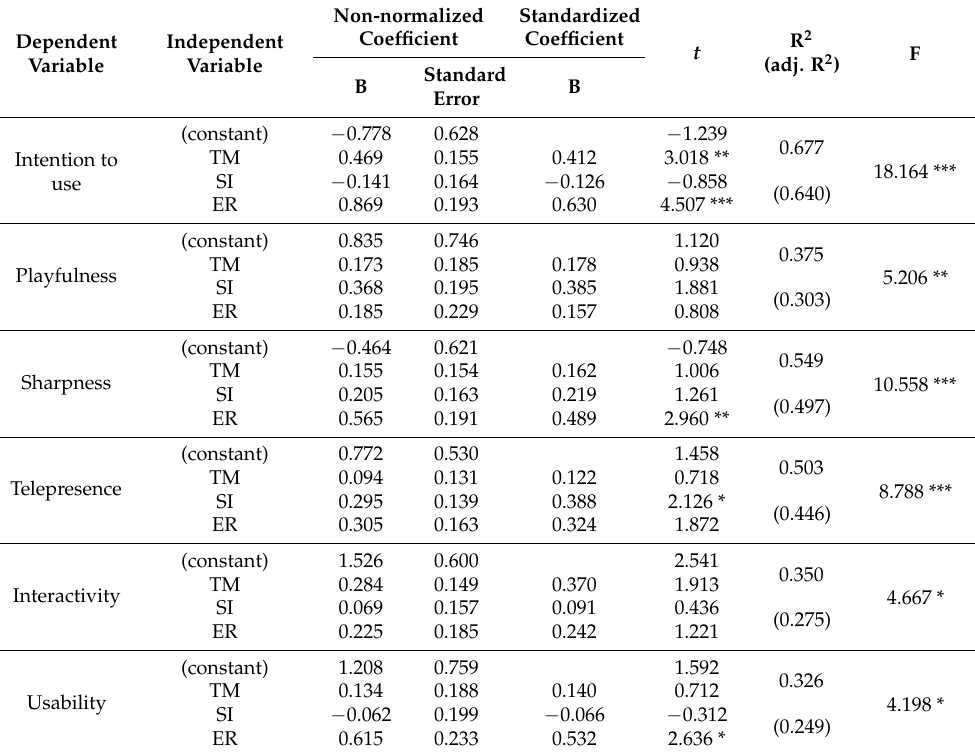
Table 8. Results of multiple regression analysis for non-immersive VR. * p < 0.5; ** p < 0.05; *** p <